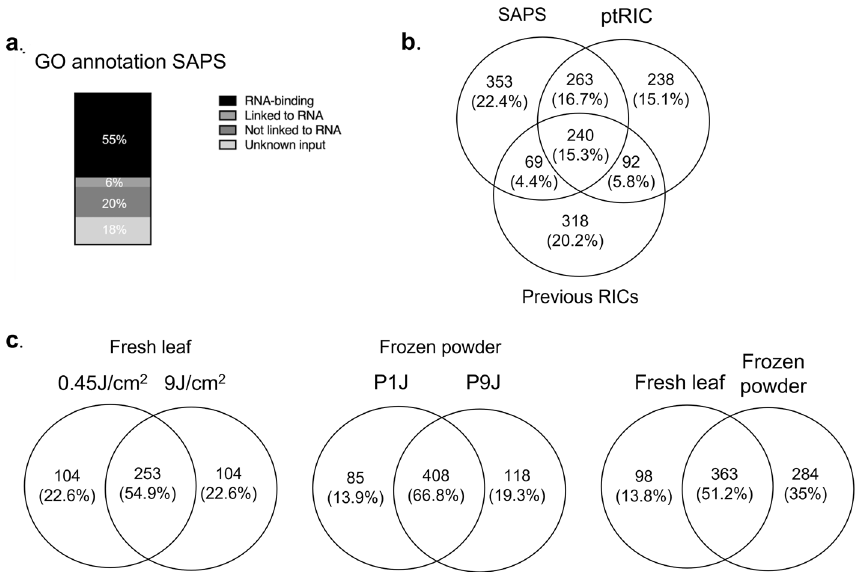
Figure 8. ( a ) An insight into the RBPome of Arabidopsis thaliana leaf tissue isolated by SAPS; the distribution of the RBPome with the GO annotation RNA-binding, linked to RNA, not linked to RNA or proteins with currently unknown functions. ( b ) Comparison of the number of identified RBPs defined by SAPS, ptRIC and previous RIC experiments summarized by Hentze et al. 2 . ( c ) Overlap between the RBPomes of the different sample conditions. The first Venn diagram compared cross-linking conditions (0.45 J and 9 J) on fresh leaves. The second diagram compares UV cross-linking performed on frozen leaf (P1J and P9J). The comparison of fresh leaf and frozen powder conditions is depicted in the third